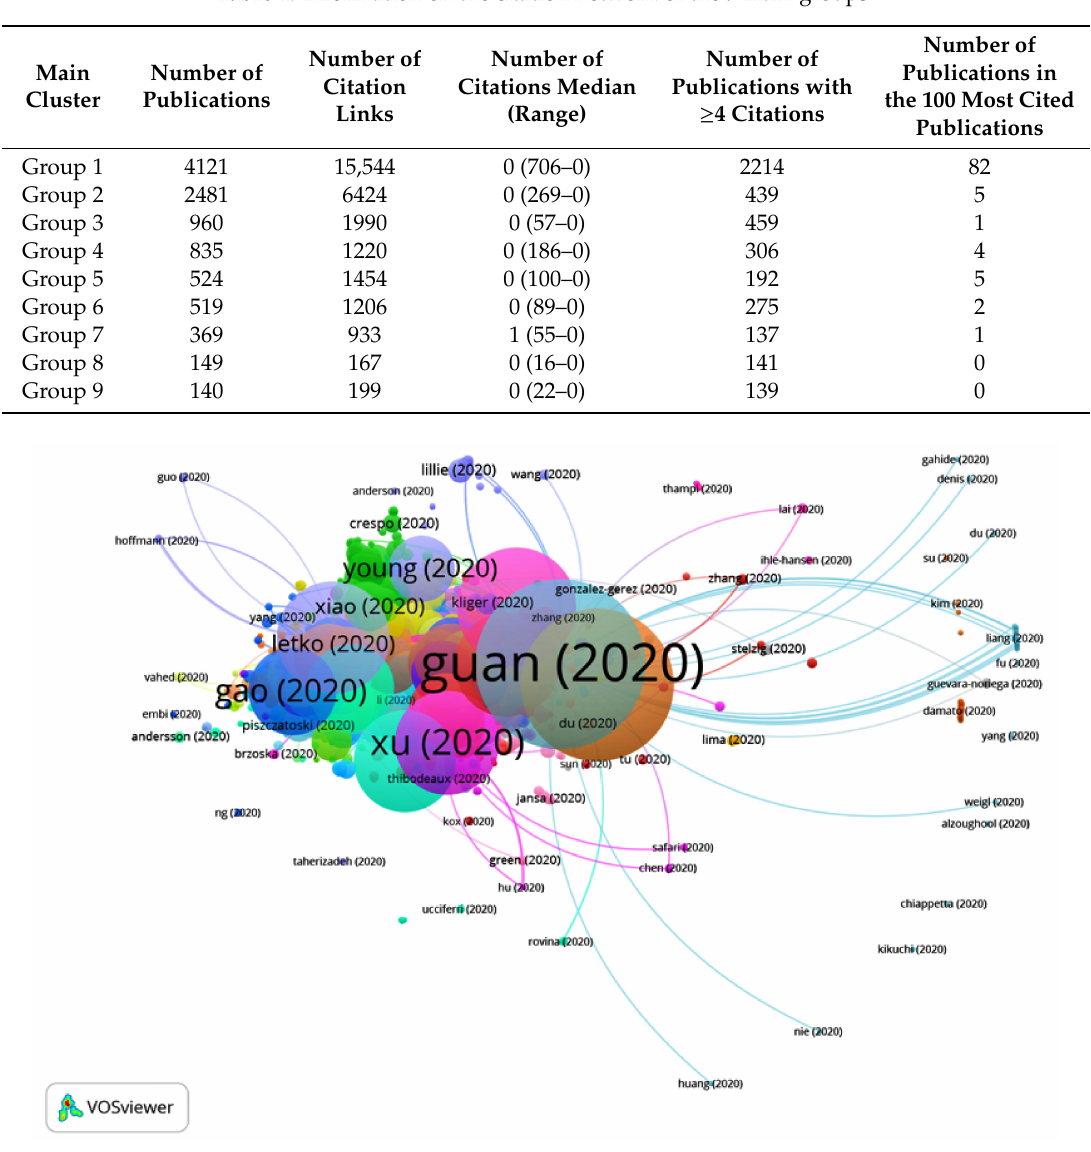
Figure 7. Citation network for Group